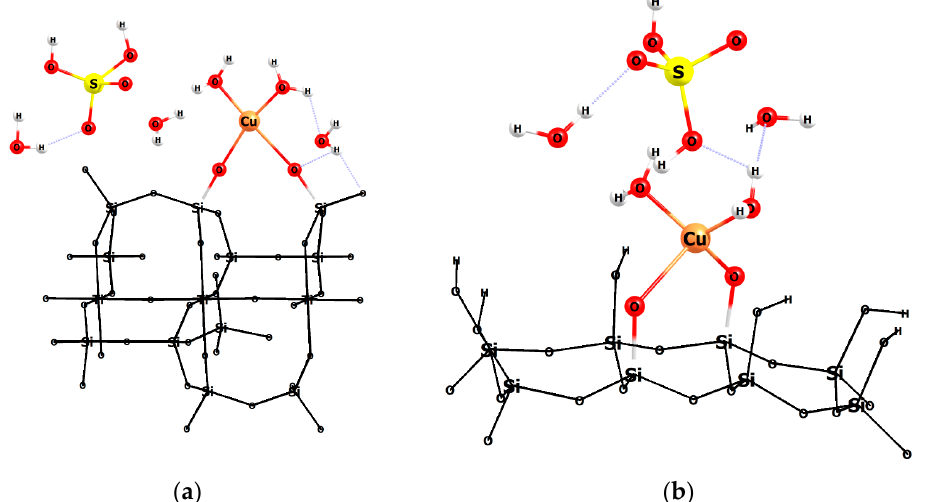
Figure 9. The configuration of Cu atom in interactions with porous surface: ( a ) square planar; ( b ) tetrahedral.